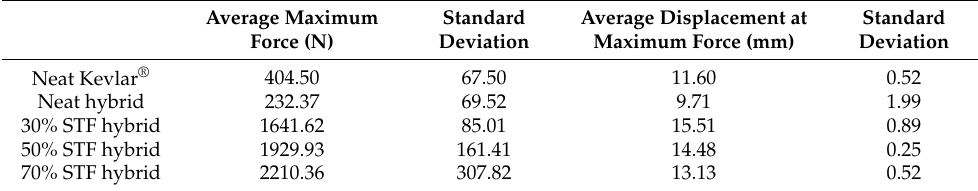
Table 2. Summarized Results of Kevlar ® and Hybrid STF Sample Puncture Resistance